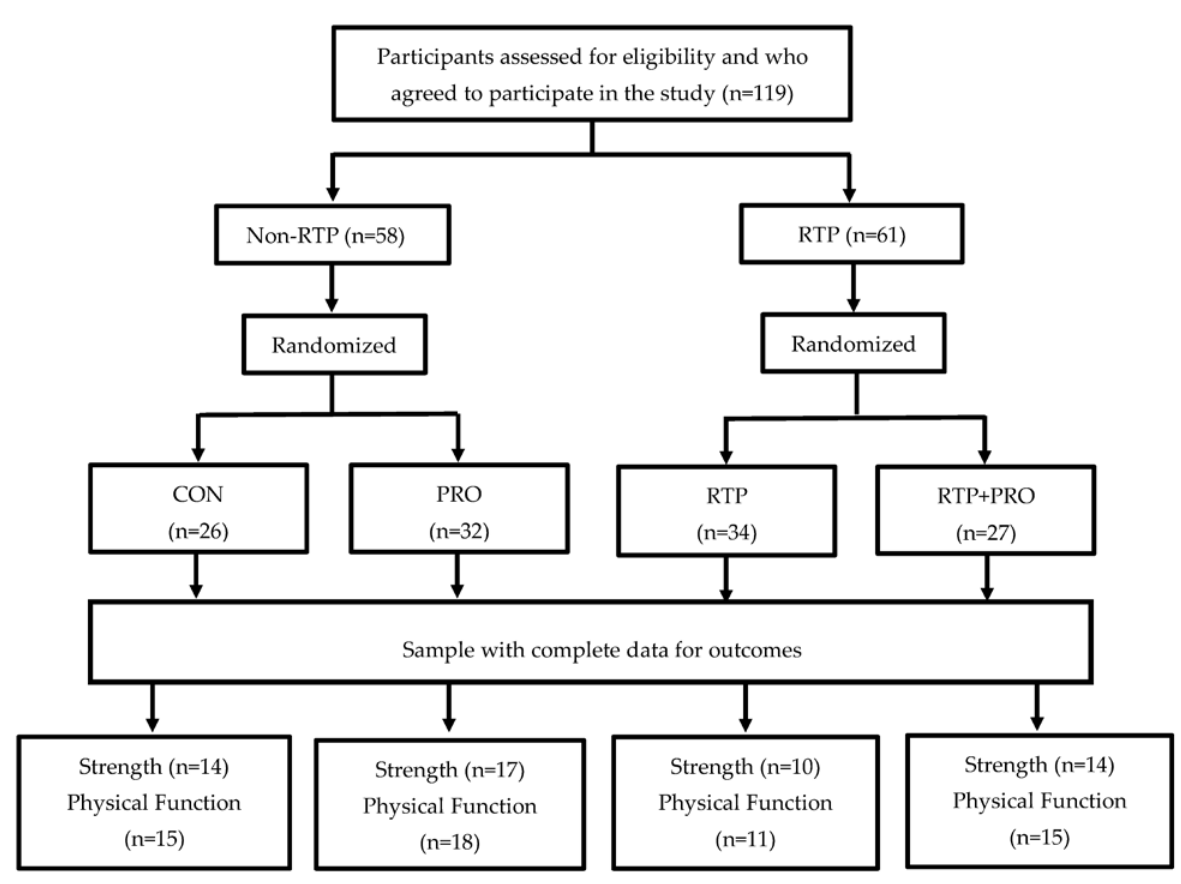
Figure 1. Flowchart of the participants allocation process, sample randomization, and dropout rates at each stage of the study. CON: control; PRO: whey protein supplementation; RTP: resistance training program.